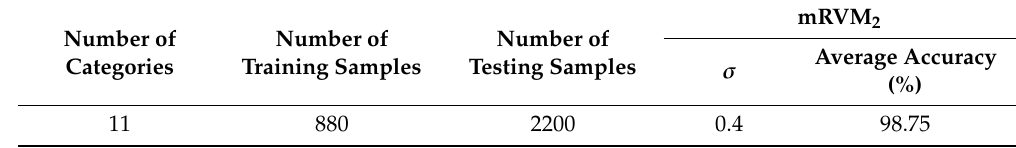
Table 7. Fault type and diameter identification irrespective of the load.